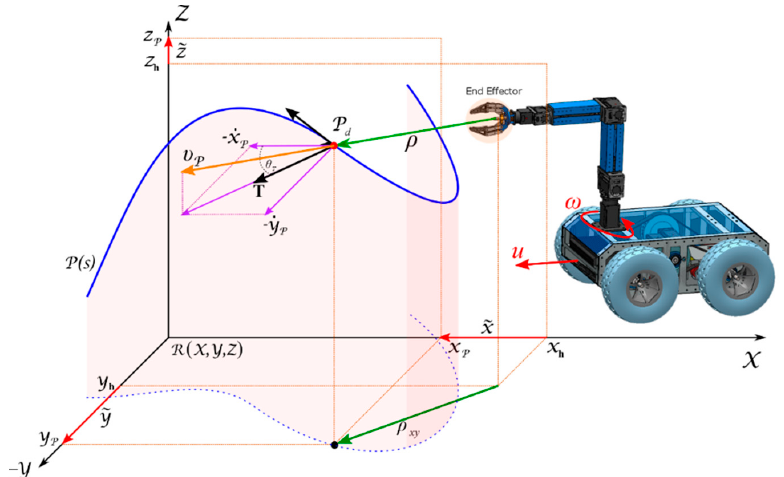
Figure 2. Path Figure 2. Path Tracking.